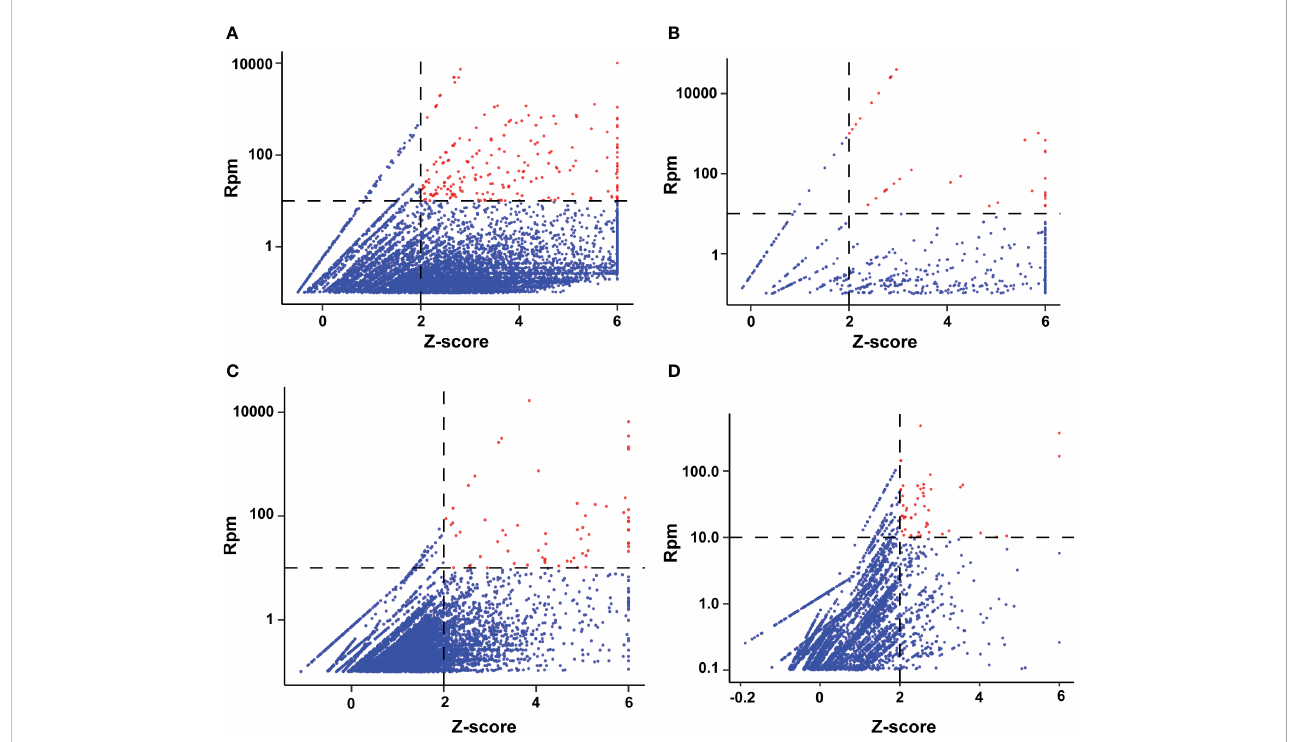
FIGURE 1 Distribution of microbial abundance and z-score detected by mNGS of BALF samples. (A) Bacteria; (B) Viruses; (C) Fungi; (D) Protozoa. An rpm value of <0.01 abundance defaults to a log10 (rpm) of − 2 for that microorganism in that sample, and a z-score pf >6 defaults to 6 for all samples. The red dots represent potential pathogens in our selected